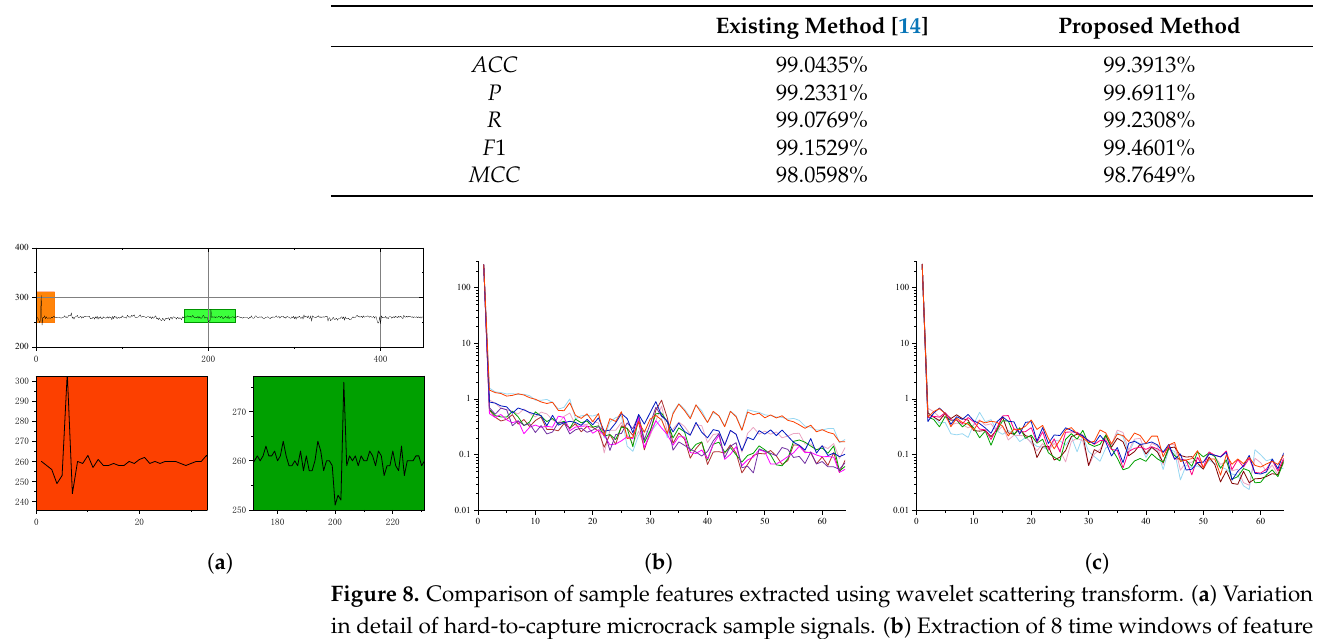
Table 4. Comparison of the results of the dataset used in the existing method [14].